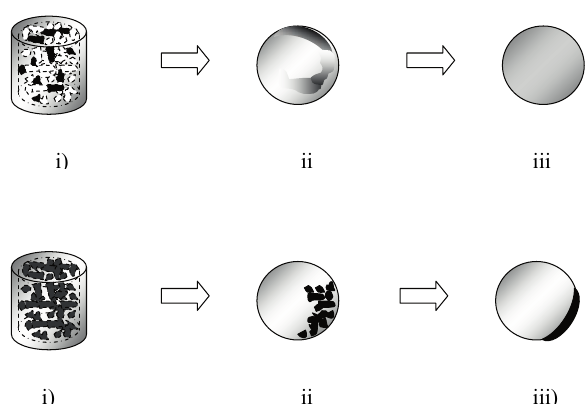
Figure 1. Schematic illustration of in-situ alloying (a) and slag forming (b).